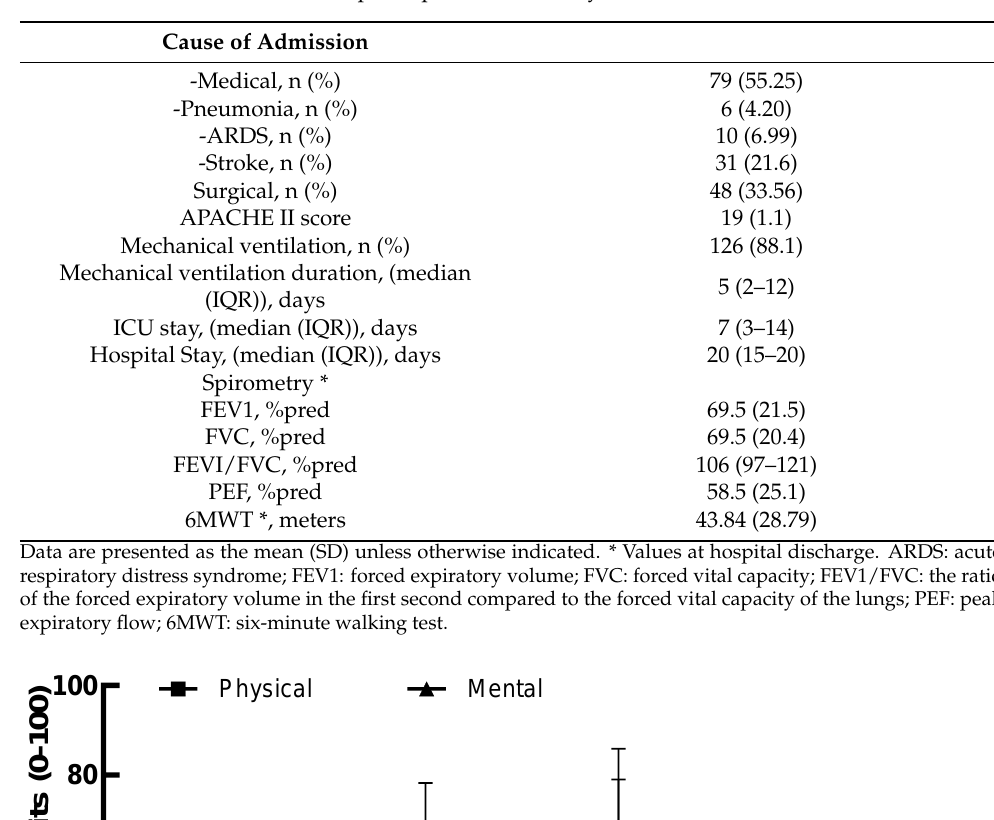
Table 2. Clinical characteristics of participants in the study.